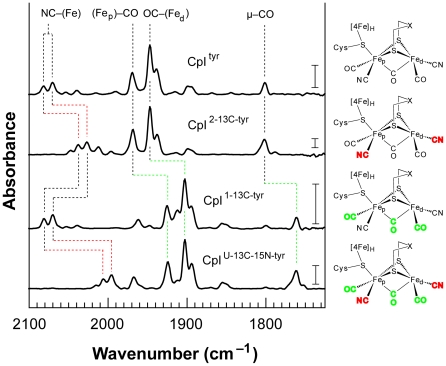
FTIR spectroscopic analysis for active CpI produced in vitro using natural abundance tyrosine or isotopically labeled tyrosine analogs.The IR spectra are for the as-isolated active CpI hydrogenase containing the H-cluster produced in the presence of L-tyrosine (CpItyr), L-[2-13C]-tyrosine (CpI2-13C-tyr), L-[1-13C]-tyrosine (CpI1-13C-tyr), and L-[U-13C-15N]-tyrosine (CpIU-13C-15N-tyr). The shifts in vibrational energies correlate with expected changes for ν(13CO), ν(13CN), and ν(13C15N) modes, confirming that the CO and CN− ligands are synthesized from tyrosine. Labels indicating the assigned ν(CO) and ν(CN) vibrational modes are provided at the top of the figure, with the 13CN−/13C15N− and 13CO ligands shown in red and green, respectively, in the molecular diagrams. Vertical scale bars provided at 1740 cm−1 represent a difference of 0.5 milliabsorbance units. Table 2 summarizes the vibrational energies and corresponding assigned ν(CN) and ν(CO) modes for the Hox clusters.